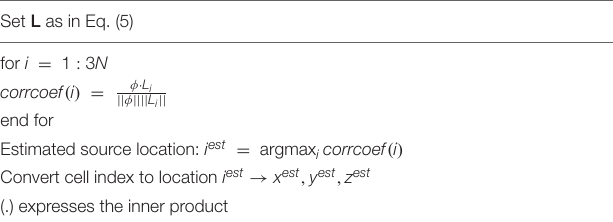
TABLE 2 | Pseudo code of proposed algorithm based on matching pursuit. Set L as in Eq.